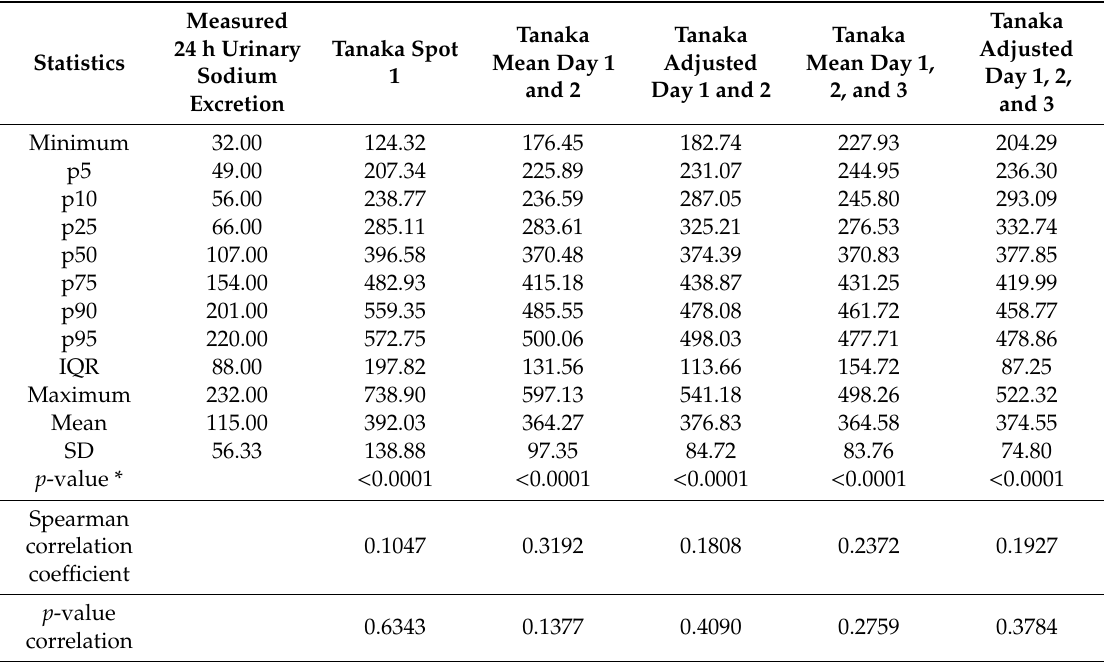
Table 5. Prediction equations to estimate 24 h Na using correction applied for both spot Na and spot Cr using the Tanaka equation (mmoL / day).